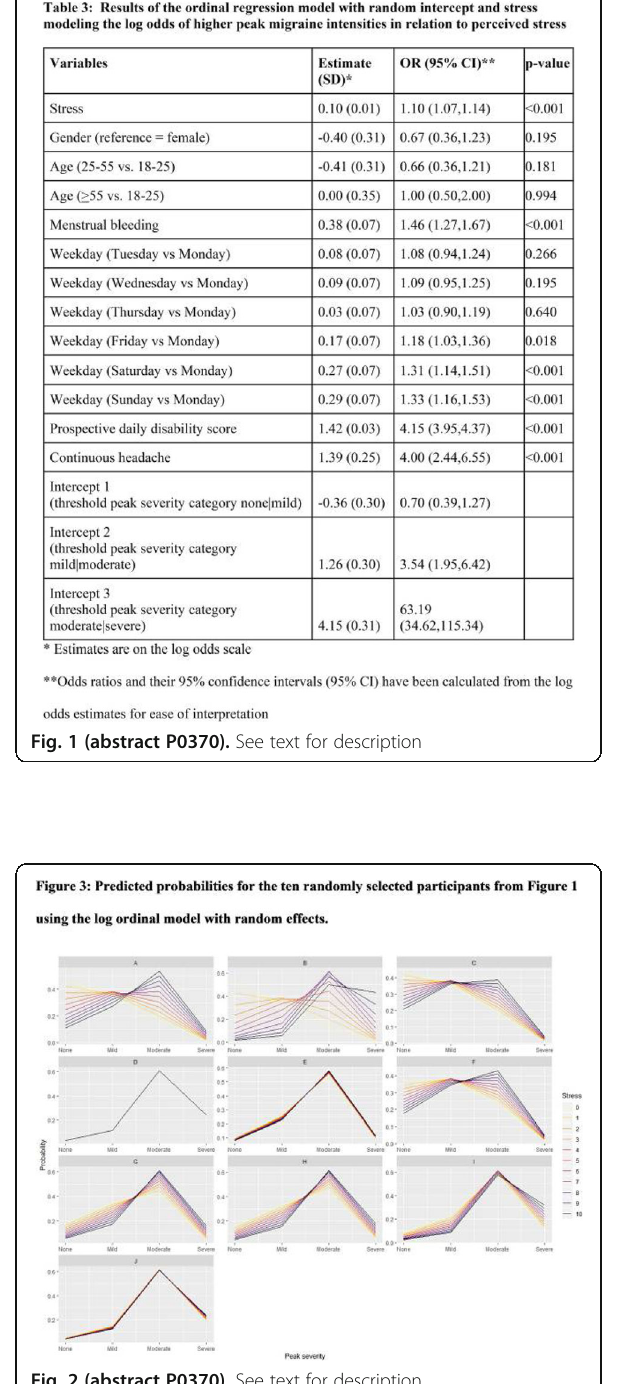
Fig. 2 (abstract P0370). See text for